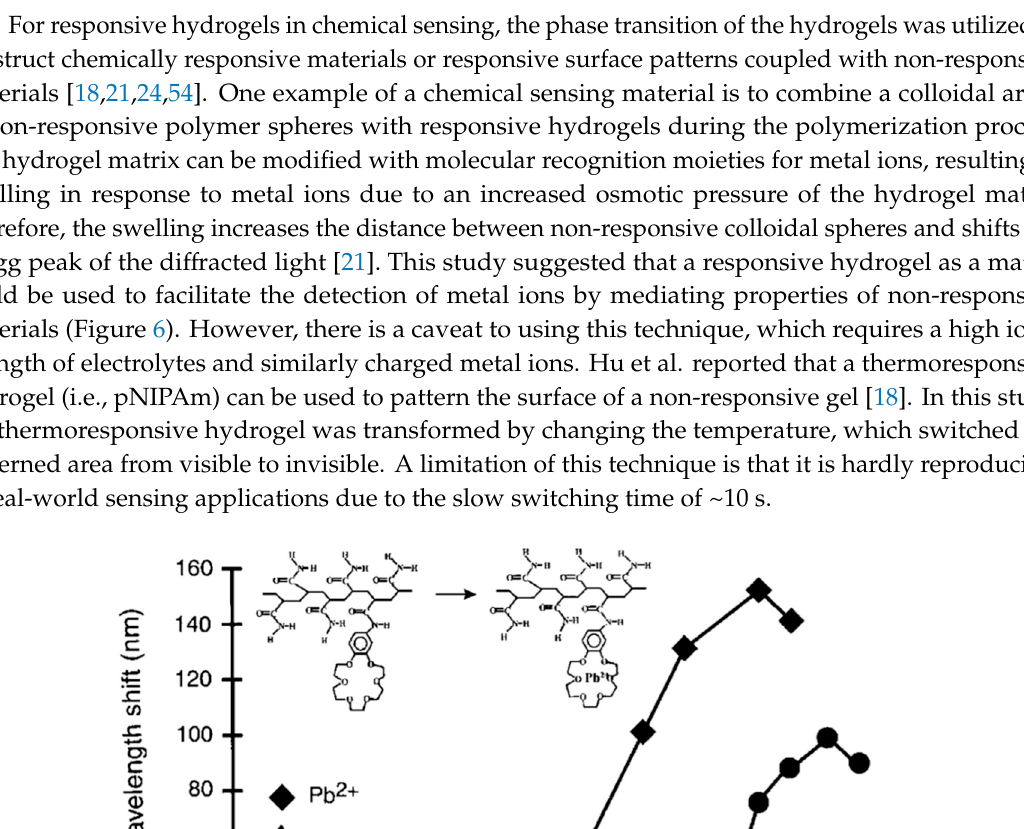
Figure 5. Insulin release rate of insulin-loaded hydrogels as a function of electric current [33]. Reproduced from [33] with permission. Copyright (1991) Springer Nature.